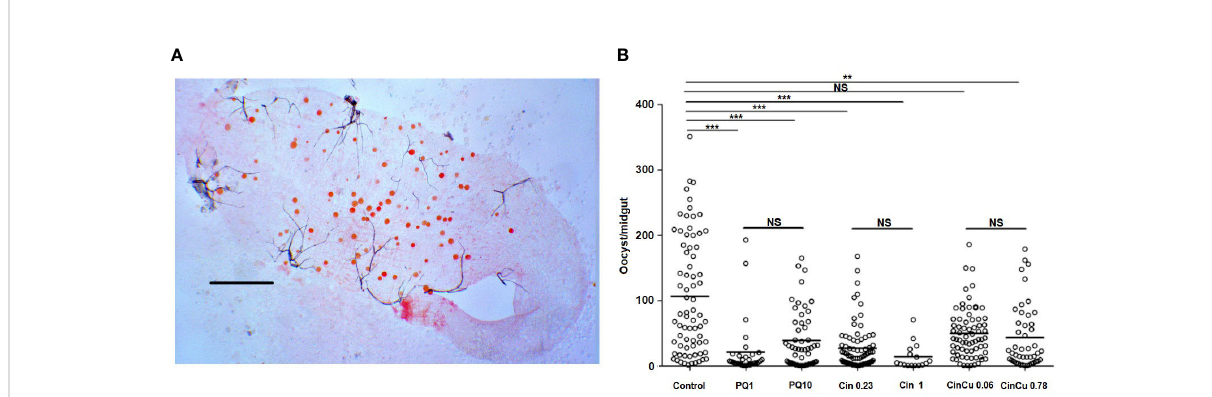
FIGURE 6 Oocyst infection intensity of P. vivax in A . aquasalis after feeding on blood treated with cinchonine, primaquine, and CinCu. (A) Representative image of P. vivax oocysts in the midgut of A . aquasalis; the slide was stained with 2% commercial Mercurochrome (Merbromin); scale bar: 250 µm. (B) Number of oocysts per midgut of A . aquasalis after blood meal. PQ 1: primaquine 1 µg/mL; PQ 10: primaquine 10 µg/mL; Cin 0.23: cinchonine 0.23 µg/mL; Cin 1: cinchonine 1 µg/mL; Cin+Cu 0.06: cinchonine in association with copper at 0.06 µg/mL; Cin+Cu 0,78: cinchonine in association with copper at 0.78 µg/mL NS: non-signi fi cant, ** p<0.01, *** p<